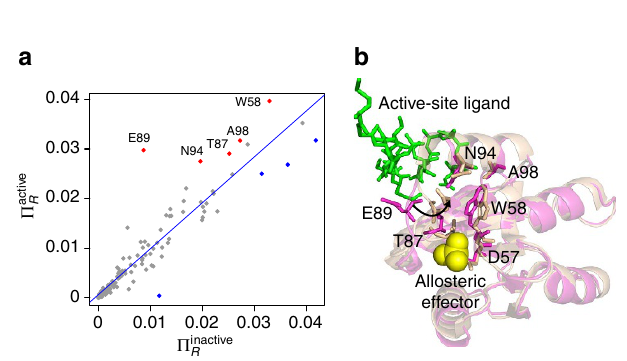
Figure 3 | Comparison of residue propensities between active and inactive conformations of CheY. ( a ) The propensities most increased in the active X-ray structure (1F4V) as compared with the inactive X-ray structure (3CHY), as identified by Cook’s distance, are coloured red and labelled. ( b ) Superposition of active (1F4V—beige) and inactive (3CHY—pink) conformations. The residues found in a form a pathway between the allosteric site and the ligand-binding surface.